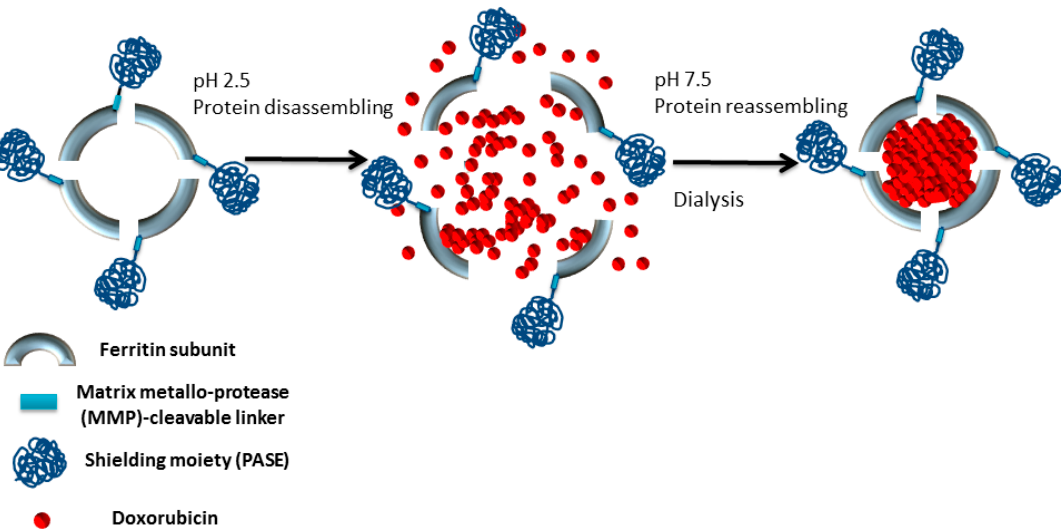
Scheme 1. Schematic representation of the synthesis of HFt-MP-PAS40-Dox. For clarity purposes, only 4 out of the 24 modified HFt N-termini are